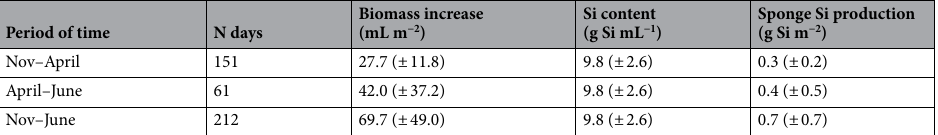
Table 1. Summary of average (± SD) growth and silicon production rates of Hymeniacidon perlevis during regeneration. The total regeneration period (mid-November to mid-June, 212 days) was explored in two intervals: (1) from mid-November to mid-April, and (2) from mid-April to mid-June. Metadata and tracked calculations are available in Supplementary Information